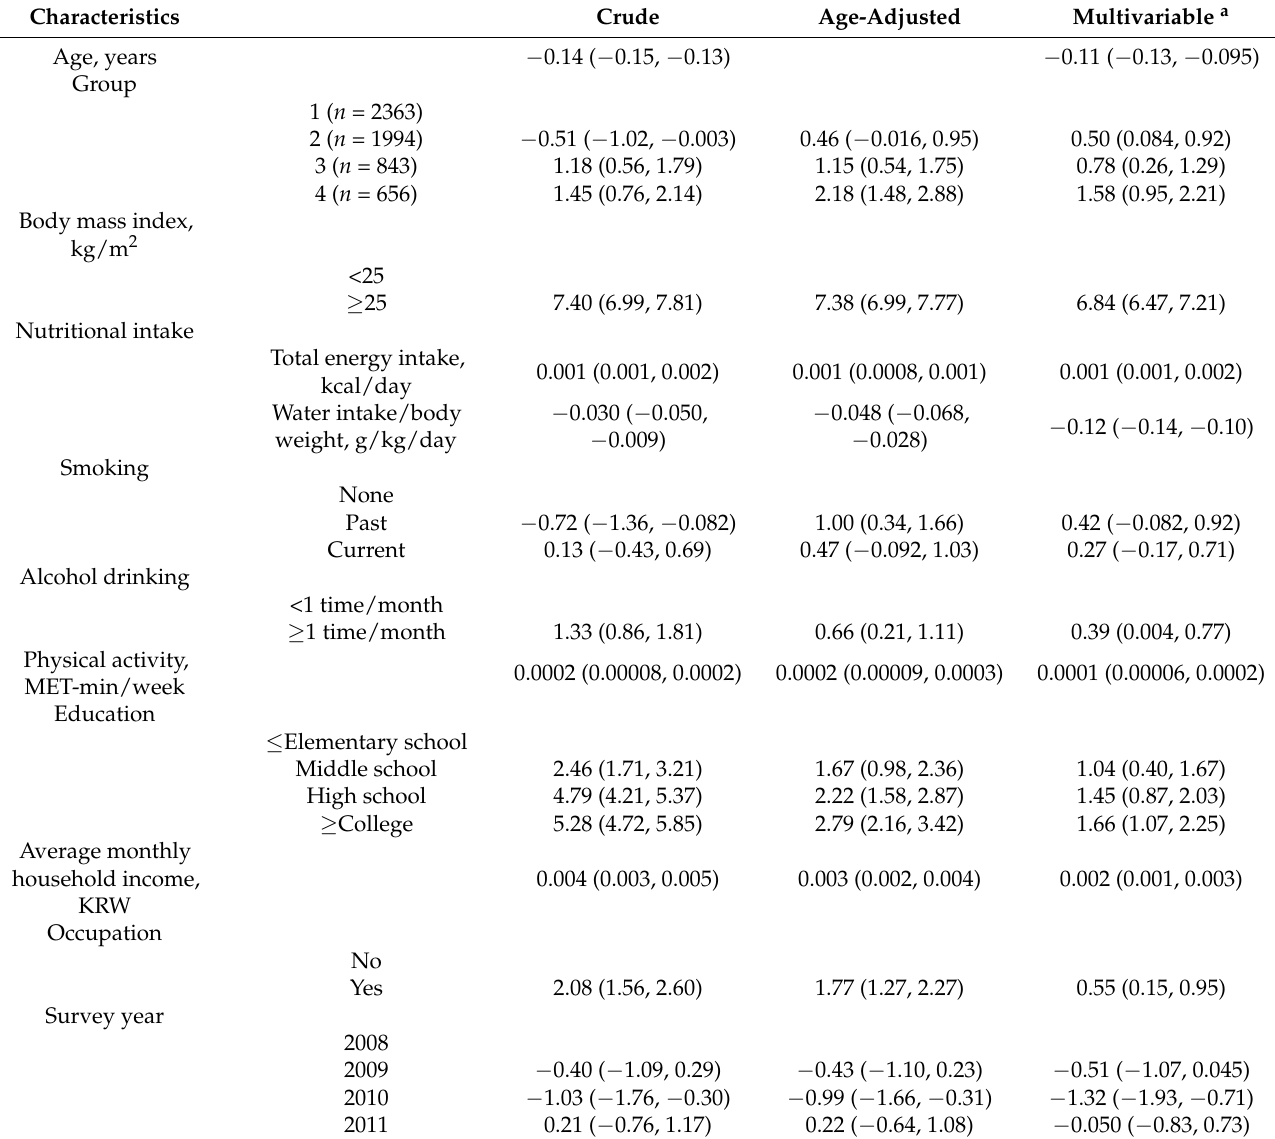
Table 4. Linear regression analysis of changes in whole body total fat-free mass by group in